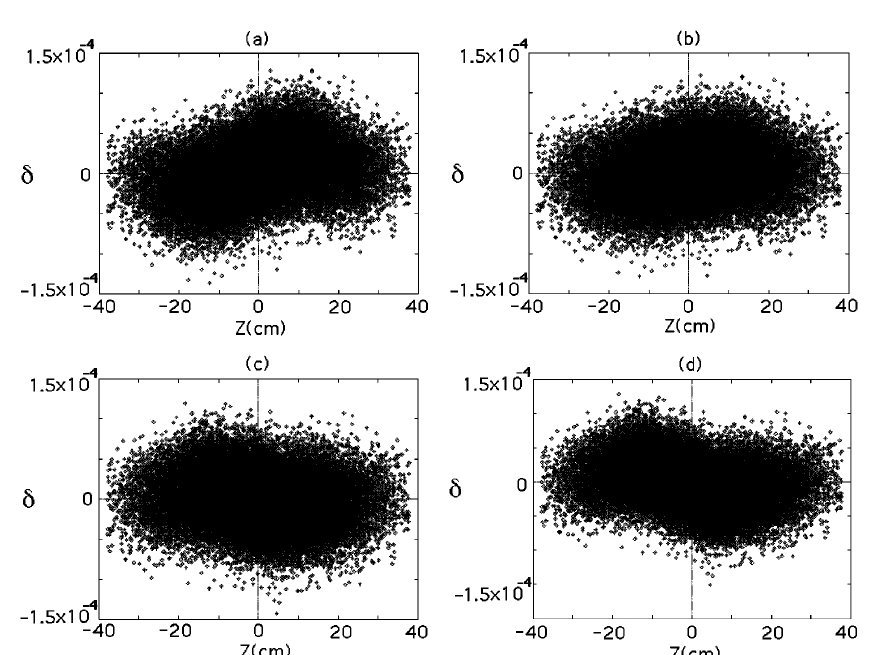
FIG. 4. The sensitivity of the longitudinal beam phase space to the variations of the bunch current. The number of particles in a bunch is varied from the design value by 2 (cid:49)(cid:48)(cid:37) , 2 (cid:53)(cid:37) , 1 (cid:53)(cid:37) , and 1 (cid:49)(cid:48)(cid:37) in (a)–(d), respectively. Two rf voltages are held fixed at the values used in Fig. 3, in (a)–(d). In addition, s d (cid:173) (cid:51) 3 (cid:49)(cid:48) 2 (cid:53) , h (cid:49) (cid:173) 2 (cid:49) 3 (cid:49)(cid:48) 2 (cid:54) , and j (cid:90) k